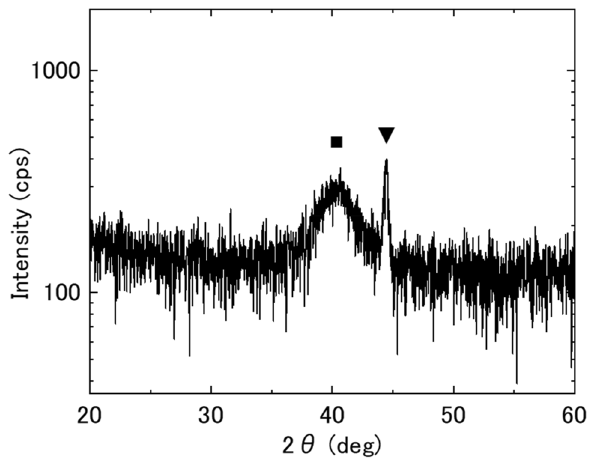
Figure 1. XRD profile of Pd 75 Cu 10 Si 15 thin film on Si(100). There are two peaks: a broad peak ( ■ ) around 40 degrees from the amorphous structure and a sharp peak ( ▼ ) around 45 degrees from partial crystallization of Pd(200) or